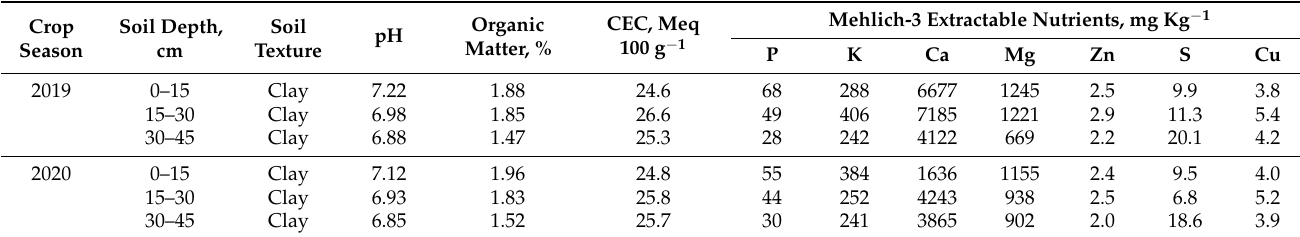
Table 2. Selected soil (Dundee silt loam) physical and chemical properties of the experimental site in Stoneville, MS, in 2019 and 2020.